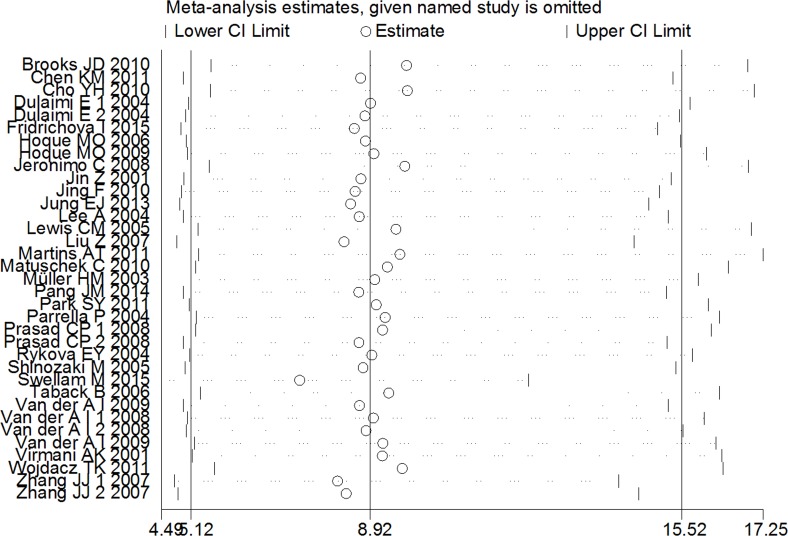
Sensitive analysis of pooled OR based on the random effects model.The results were calculated by omitting each study in turn. The circles represent the individual studies in this meta-analysis. The two ends of the dotted lines represent the 95% CI. OR represents the odds ratio. 95% CI represents the 95% confidence interval.